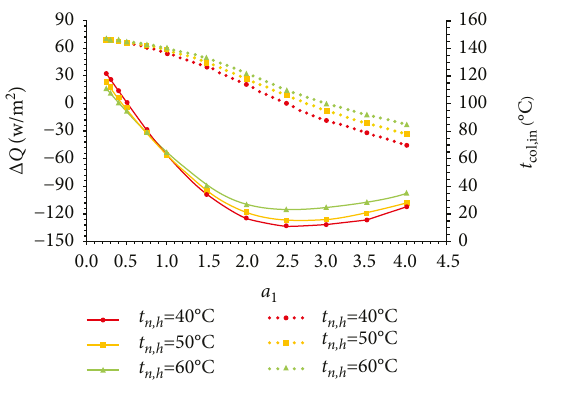
Figure 9: The value of Δ Q and the inlet temperature of form (a) and t under di ff erent a 1 n , h